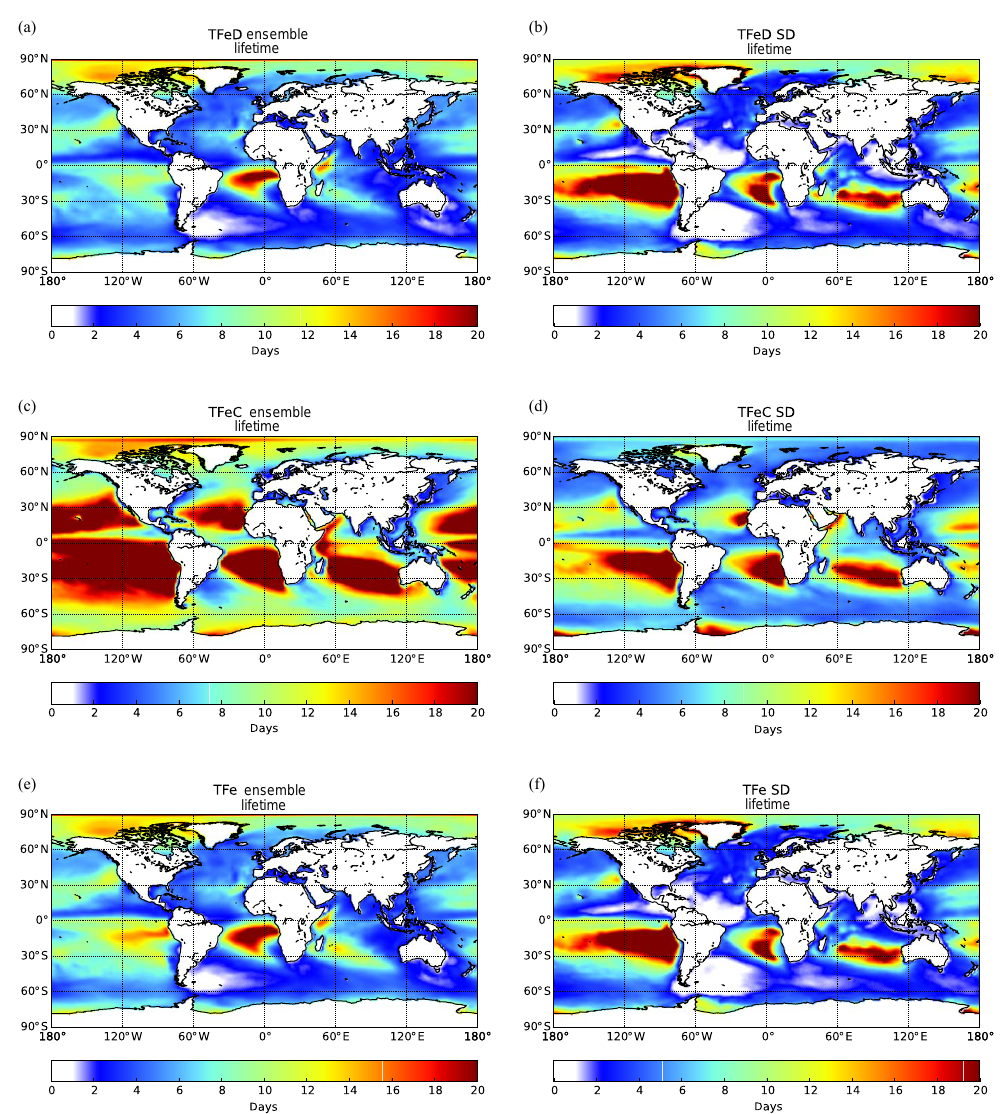
Figure 6. Ensemble model results for TFe lifetime (days) over the ocean having originated from (a) mineral dust sources, (c) combustion source, and (e) total (mineral dust + combustion) and the respective standard deviation (b, d, f) . Lifetimes are atmospheric concentrations divided by total